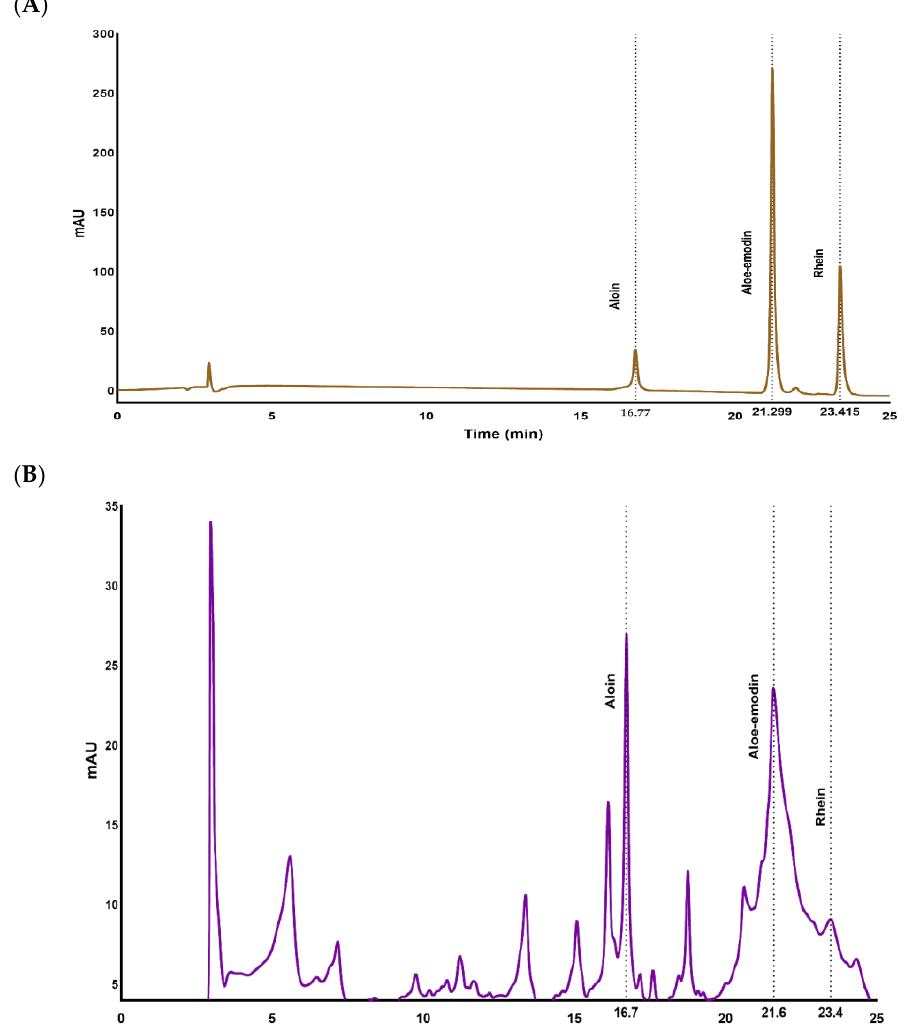
Figure 1. HPLC chromatographs of ( A ) reference standards of aloin, aloe-emodin and rhein and ( B ) HPLC chromatograms of extracted anthraquinone powder (AQ) from Aloe vera containing aloin, aloe-emodin and rhein.